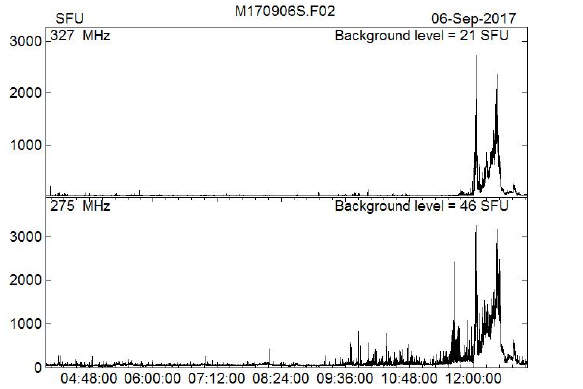
Fig. 1. Spectral fluxes of radio emission registered by RT-M. The chart clearly shows a strong radio burst that occurred at 12:02 UT with a power of 3260 SFU (1 SFU=10 -22 Wt /m 2 *Hz) at 275 MHz and 2733 SFU at 327